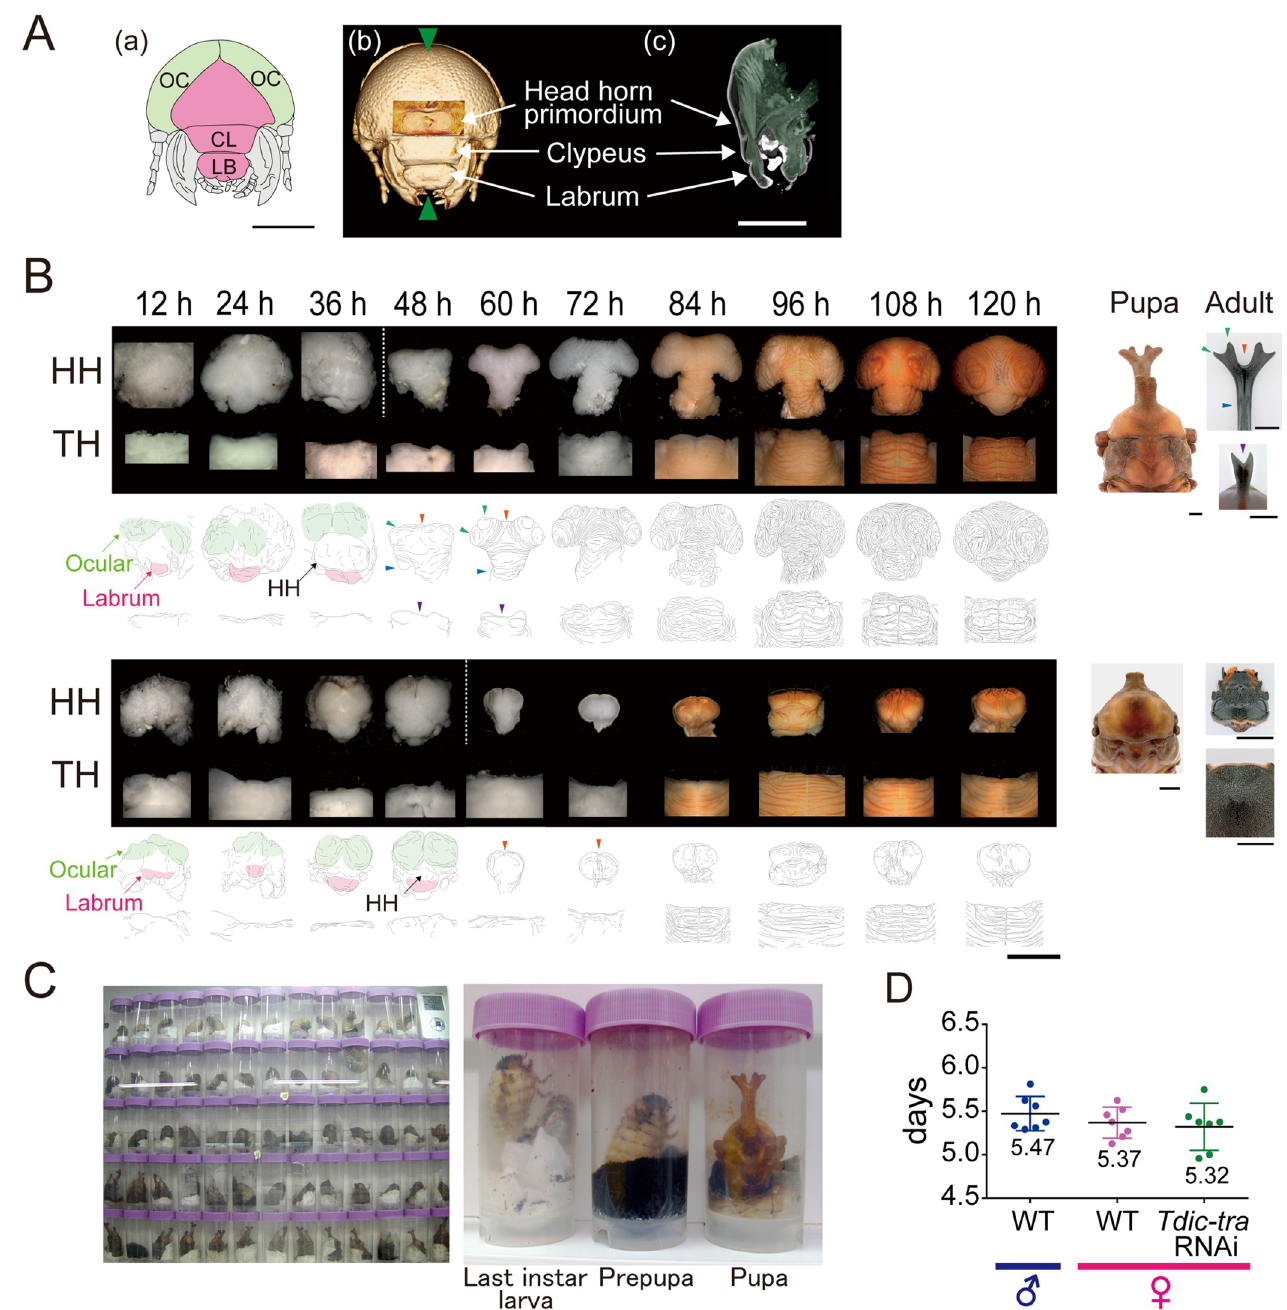
Fig 1. Morphological change of horn primordia and the prepupal period in Trypoxylus dichotomus . (A) (a) Schematic of the frontal view of larval head from T . dichotomus . Green, ocular (OC); Magenta, clypeolabrum; CL, clypeus; LB, labrum. (b), (c) Micro-CT images of prepupal head at 24 h APF from T . dichotomus . (b) The frontal view. Green arrowheads indicate the position of a sagittal section in (c). (c) The sagittal section of head. Head horn primordia were formed above the clypeus in the clypeolabrum (S1 Movie). (B) Morphological changes of head and thoracic horn primordia during larval-pupal development revealed by the time-lapse photography system. Both in males (the upper panels in the upper half) and in females (the upper panels in the lower half), horn primordia were formed in the clypeolabrum. In males, the frontal views are presented concerning the head horn primordia from 12 h APF to 36 h APF, and the anterodorsal views are presented concerning the head horn primordia from 48 h APF to 120 h APF. In females, the frontal views are presented demonstrated the head horn primordia from 12 h APF to 48 h APF, and the anterodorsal views are presented demonstrating the head horn primordia from 60 h APF to 120 h APF. The dorsal views are presented demonstrating thoracic horn primordia. APF, after pupal-chamber formation; HH, head horn primordia; TH, thoracic horn primordia; Orange arrowheads, the firstly bifurcated distal tips of a head horn; Green arrowheads, the secondly bifurcated distal tips of a head horn; Blue arrowheads, the long column shaped stalk of a head horn; Purple arrowheads, the bifurcated distal tips of a thoracic horn. Scale bars are 5 mm. (C) Snapshot images from time-lapse photography (S2 Movie). The panel on the left is a single raw image of time-lapse photography observing 64 larvae bottled in 100 ml